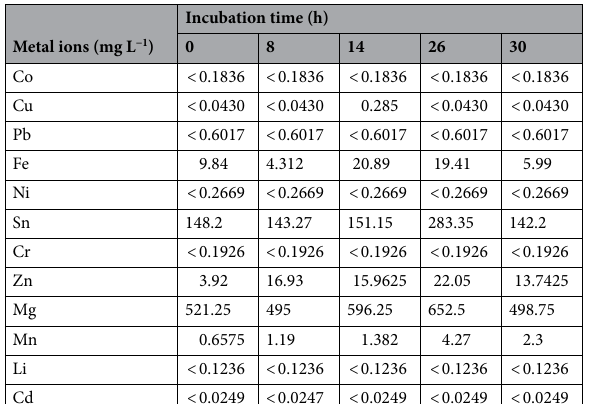
Table 6. Flame atomic absorption spectrometry for heavy metal analysis of shake-flask batch cultivation.